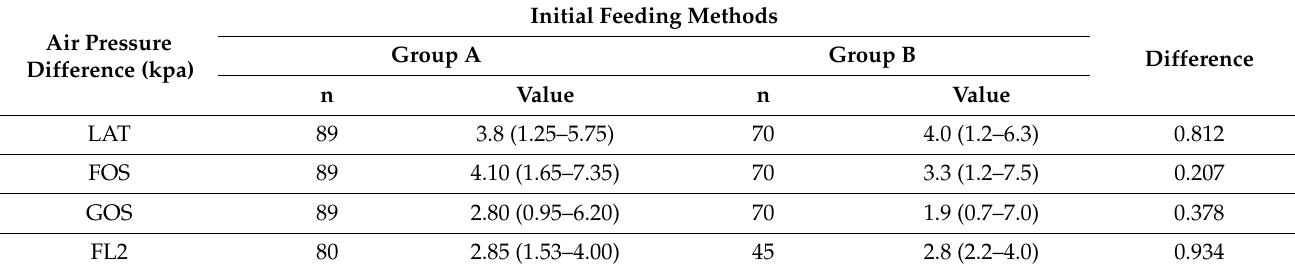
Table 3. Gas production in different media by in vitro fermentation modeling system.